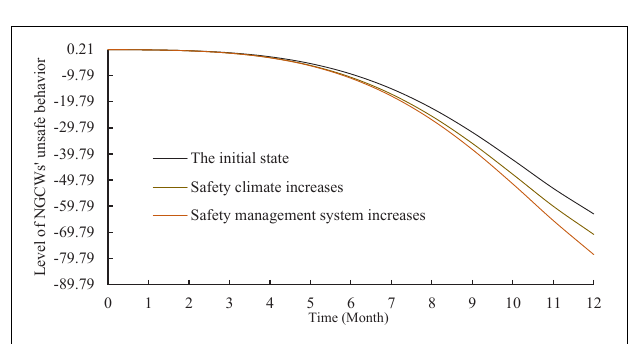
FIGURE 7 | Simulation of the effect of situational factors on unsafe